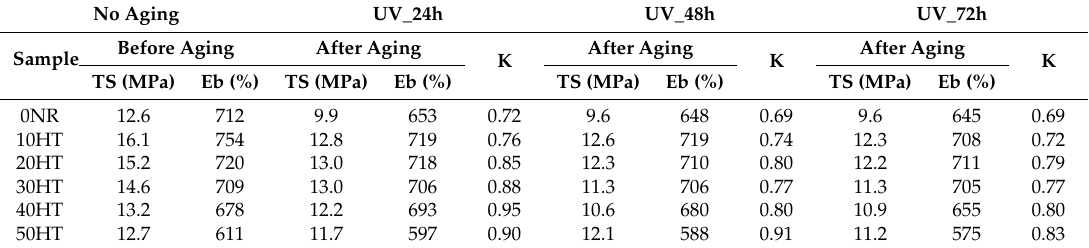
Table 5. The changes in mechanical properties before and after simulated UV aging processes and aging factor (K) for biocomposites. Standard deviations did not exceed: TS ± 0.5 MPa, Eb ± 10%, K ± 0.05.